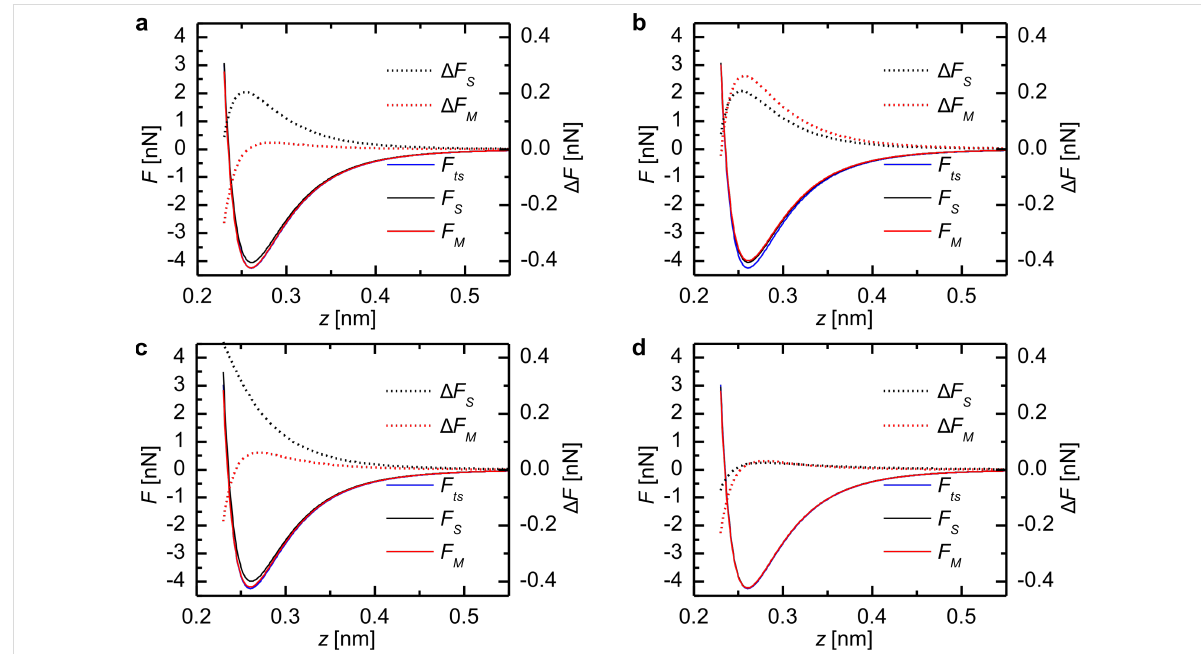
Figure 6: Model force F ts ( z ), deconvoluted force curves F S / M ( z ) and the residuals Δ F S / M ( z ) for the Lennard-Jones force law with selected oscillation amplitude. (a) Amplitude 1 in Figure 5 (11.7 pm) with R 2 = 0.9996 for the matrix method. (b) Amplitude 2 in Figure 5 (12.0 pm) with R 2 = 0.996 for the matrix method. (c) Amplitude 3 in Figure 5 (23 pm) with R 2 = 0.994 for the Sader–Jarvis method. (d) Amplitude 4 in Figure 5 (58.3 pm) with R 2 ≈ 1 for the Sader–Jarvis method.